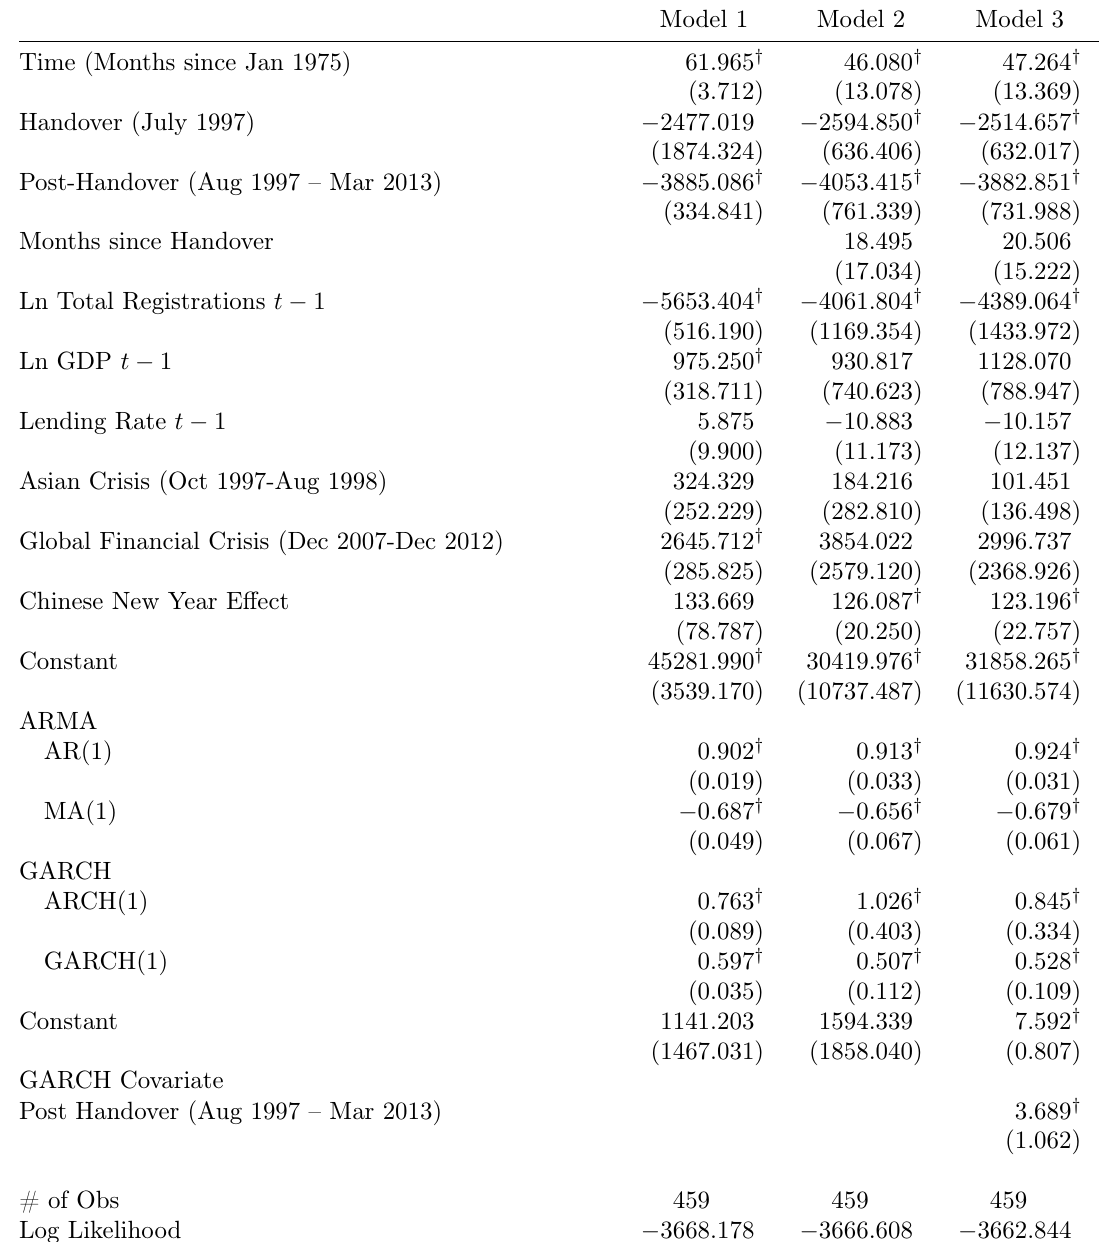
Table 1: GARCH Estimates of Effects of Handover on New Business